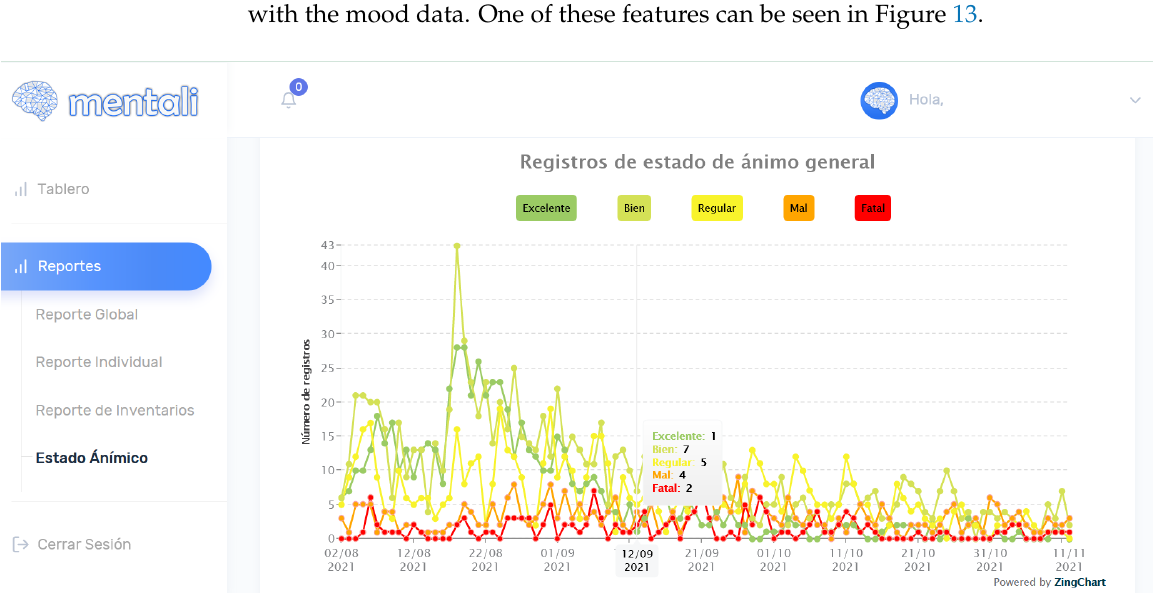
Figure 13. Mood screen—linear